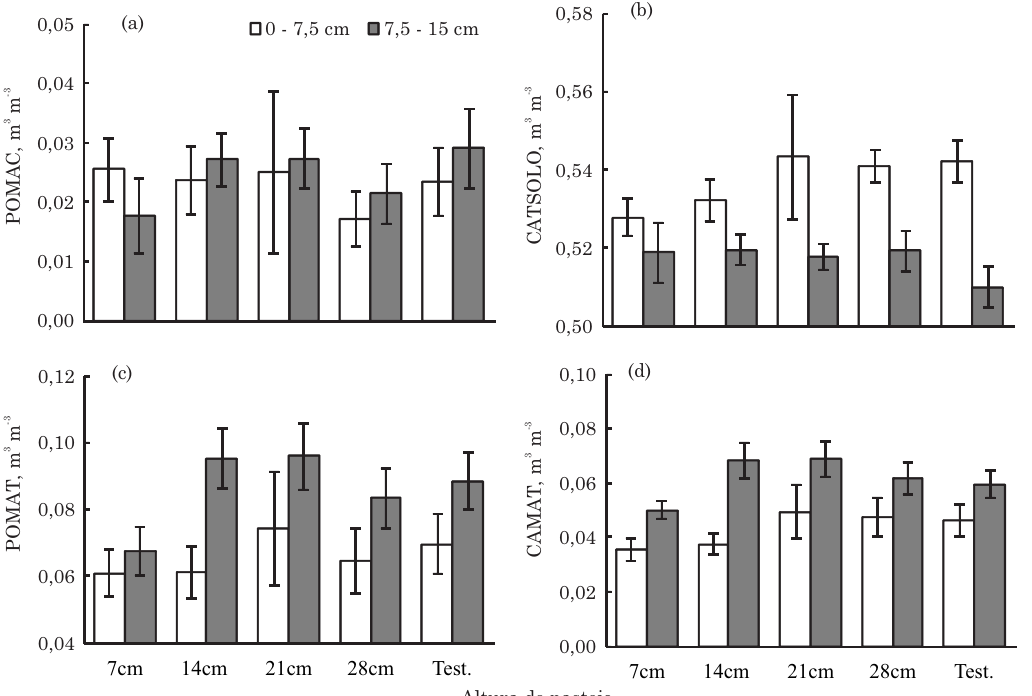
Figura 2. Porosidade no domínio dos macroporos - POMAC (a), porosidade no domínio da matriz do solo - POMAT (b), capacidade de ar no solo - CATSOLO (c) e capacidade de ar na matriz do solo - CAMAT (d), para os tratamentos de 7, 14, 21, 28 cm e testemunha (Test), nas profundiades de 0,0-7,5 e 7,5-15,0 cm. A sobreposição do intervalo de confiança da média índica ausência de diferença estatística entre os valores